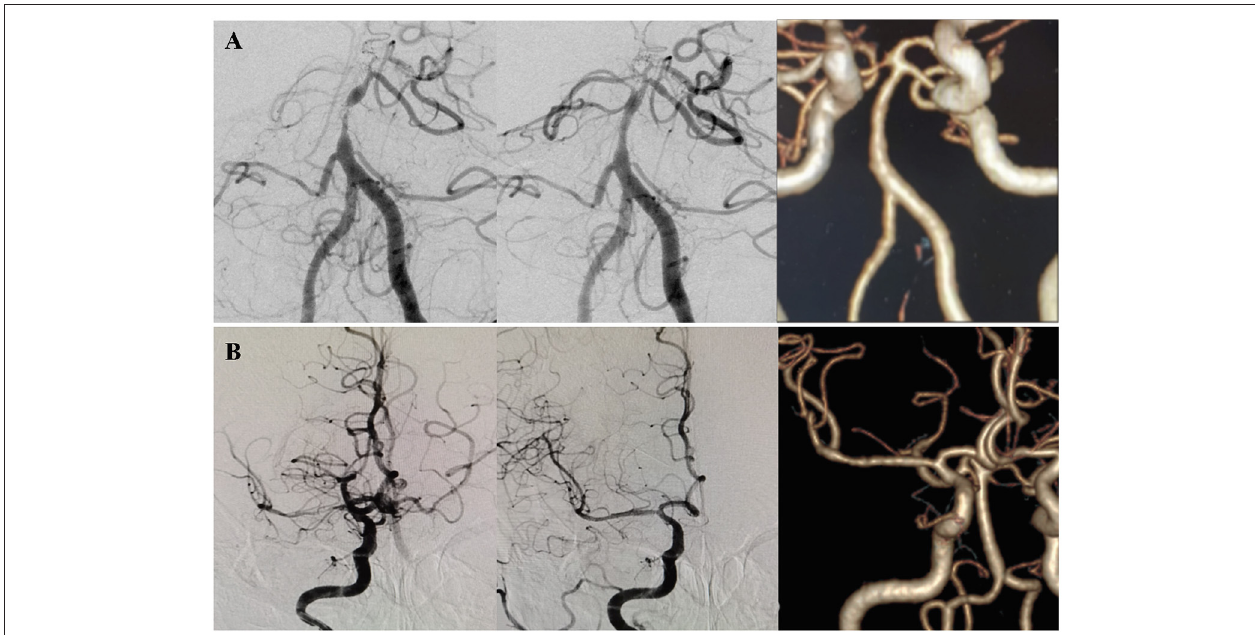
FIGURE 2 | Two patients with no significant ISR by CTA. (A) A patient presented with dizziness and diplopia for 2 months. DSA showed a high-grade ( > 90%) stenosis at the middle segment of the basilar artery, classified as Mori B type. The lesion was dilated with a 2 × 9mm Gateway balloon and implanted a 4.5 × 14mm Enterprise stent. Postoperative DSA showed the degree of stenosis decreased to 30%. CTA after 54.5 months of the procedure showed no significant ISR. (B) A patient presented with left limb weakness and dysarthria for 10 days due to a high-grade ( > 90%) stenosis at the M1 segment of the right MCA. The Mori classification was type C. The lesion was dilated with a 2 × 9mm Gateway balloon and implanted a 4.5 × 22mm Enterprise stent. Postoperative DSA showed the degree of stenosis decreased to 5%. CTA after 23 months of the procedure showed no significant ISR.